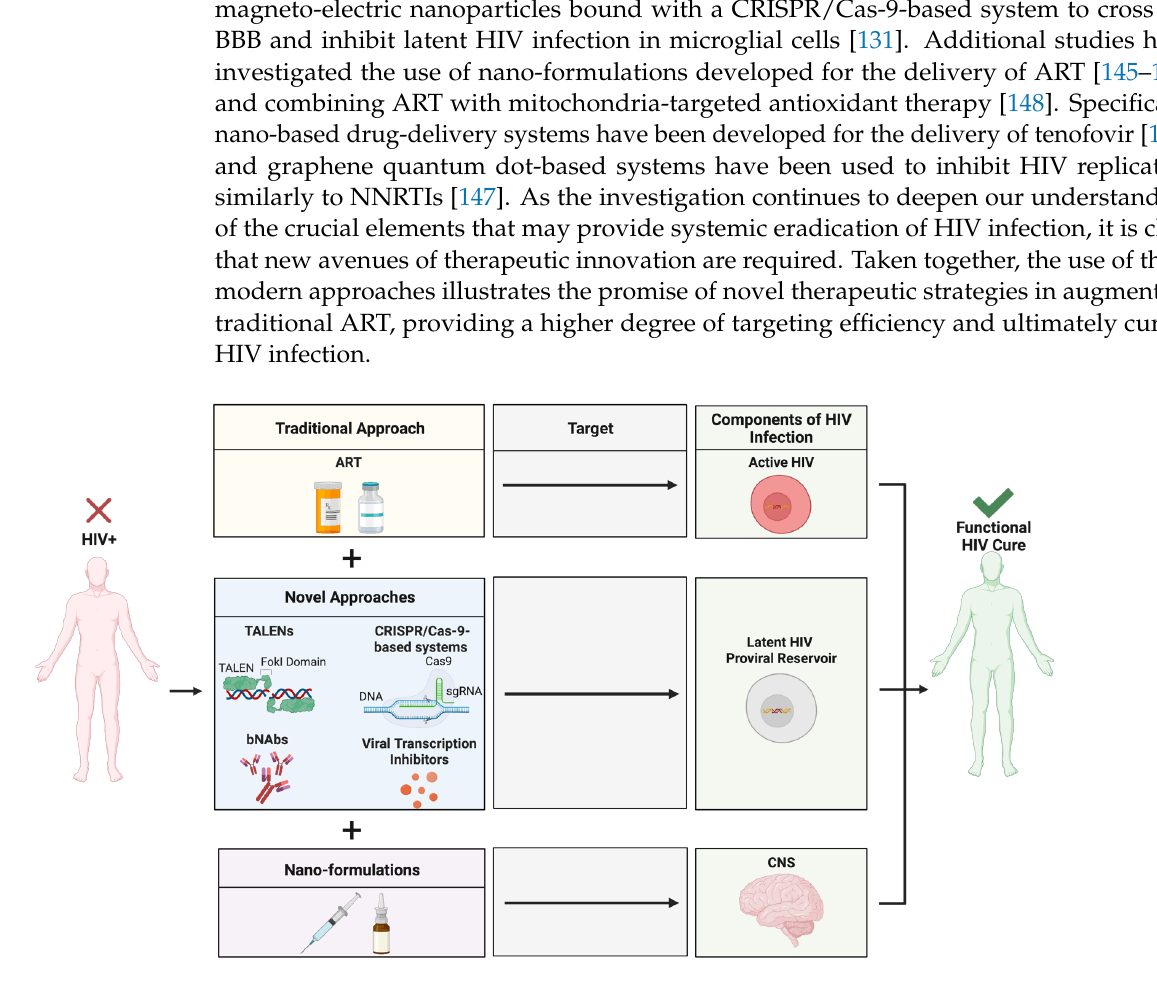
Figure 6. Novel approaches for the eradication of HIV within the CNS. A novel, multimodal drug delivery platform for anti-HIV therapeutics can result in the discovery of a functional HIV cure, allowing for the eradication of actively replicating HIV, latent proviral reservoirs, and specific targeting of the highly safeguarded CNS. Created with BioRender.com. Abbreviations: ART = antiretroviral therapy; bNAbs = broadly neutralizing antibodies; CNS = central nervous system; CRISPR/Cas-9 = clustered regularly interspaced short palindromic repeats-associated protein nuclease-9; HIV = human immunodeficiency virus; TALENs = transcription activator-like effector nucleases.